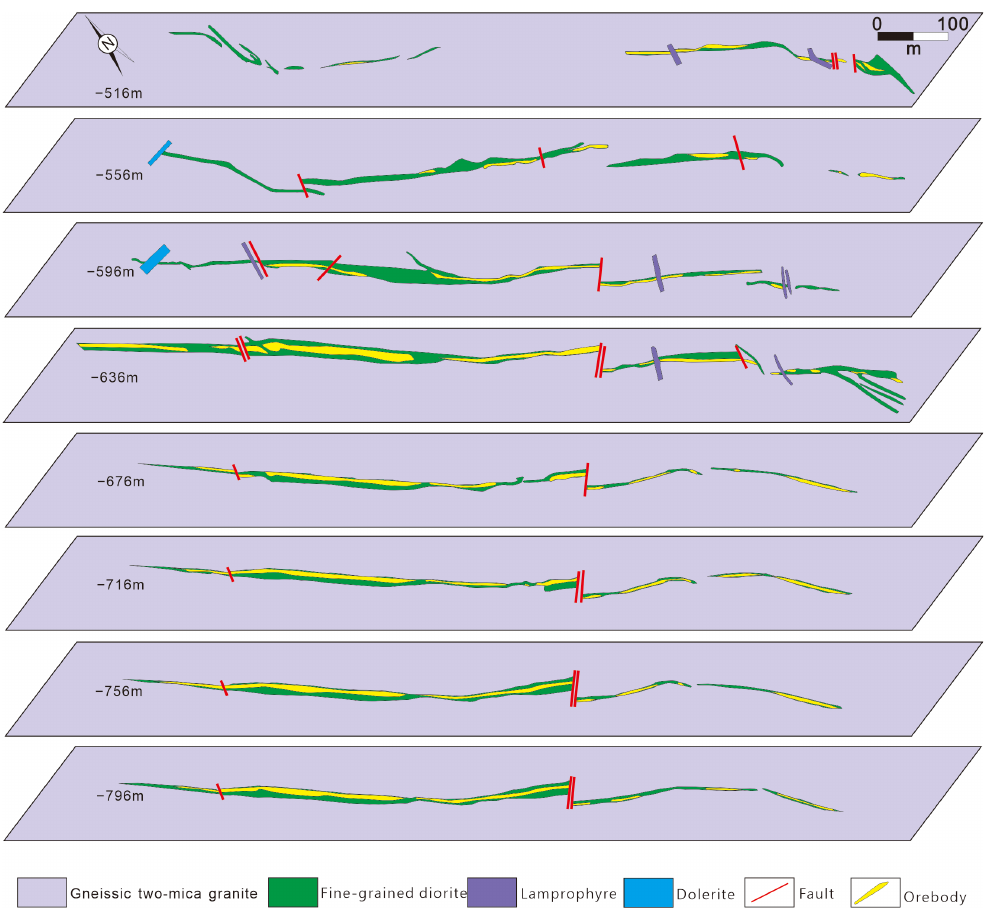
Figure 3. Geologic map of the V163 vein at different levels in the Wulong gold deposit. Modified from [12]. Mineralization at Wulong can be divided into three stages [38,42,45]: (1) quartz- pyrite, (2) quartz-polymetallic sulfide, and (3) quartz-calcite. Stage 1 and stage 2 are